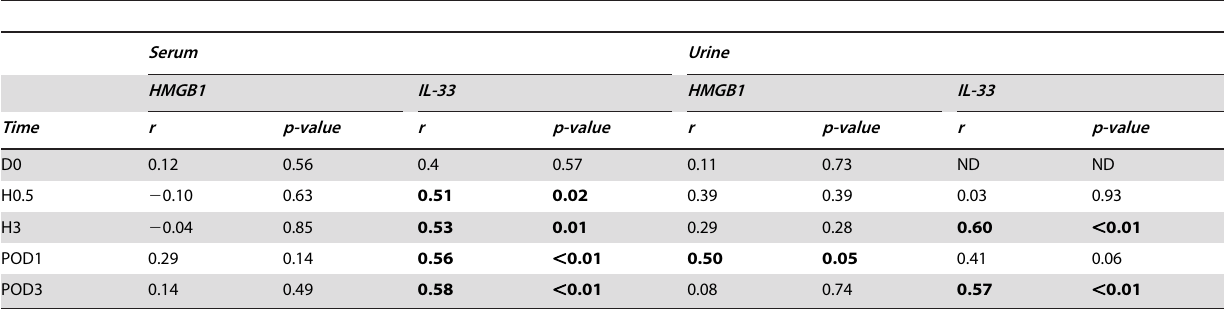
Table 2. Correlation of serum and urinary alarmin levels with cold ischemia